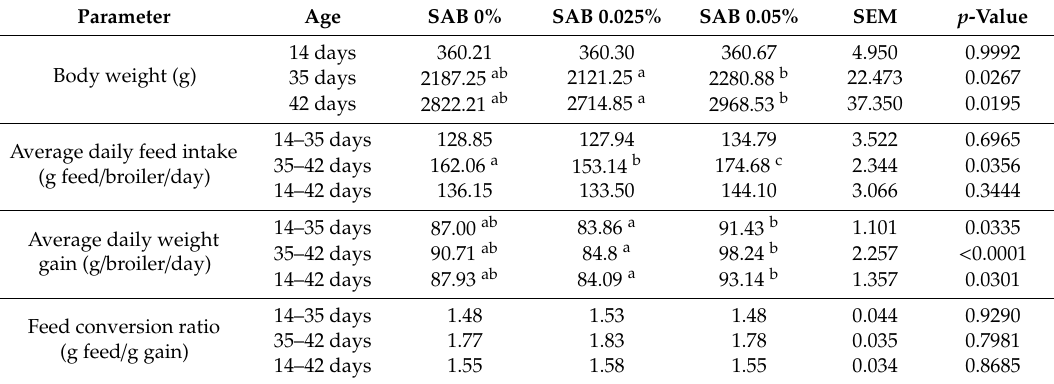
Table 2. E ff ect of dietary SAB powder on broiler productive parameters.